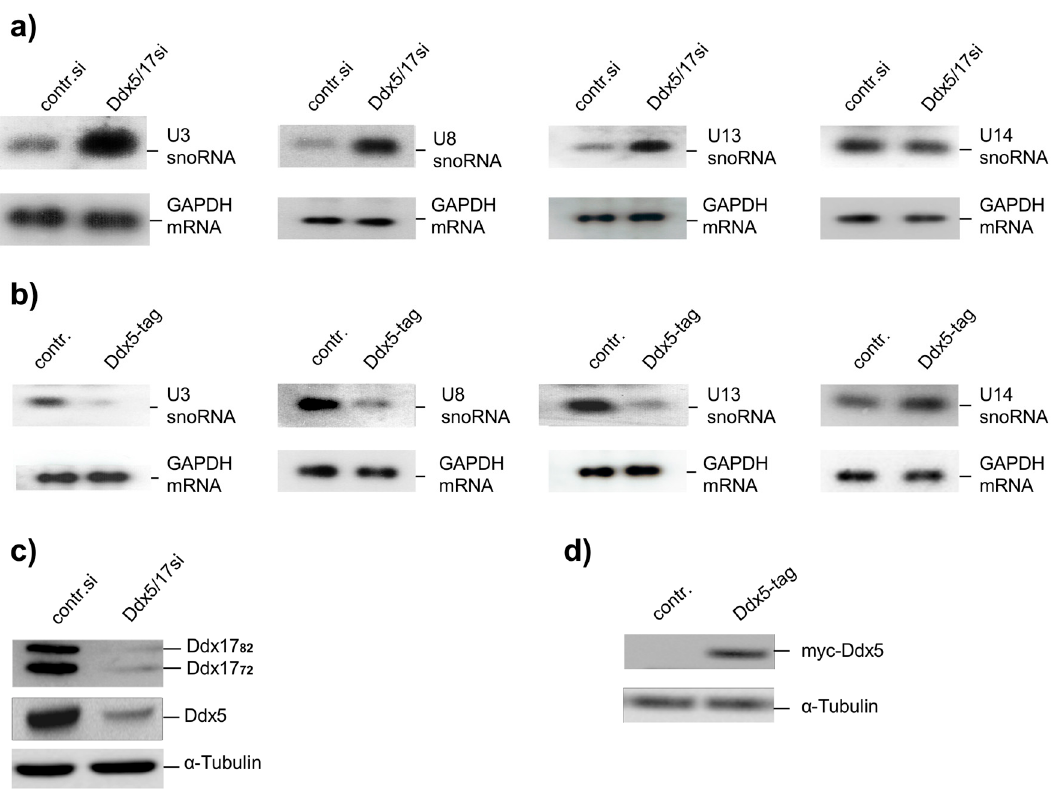
Figure 1. Effect of DEAD box proteins Ddx5/Ddx17 on the expression of U3-, U8-, U13-, and U14 small nucleolar RNA (snoRNA). ( a ) Northern blot analysis after knockdown of Ddx5/Ddx17. Total RNA (5 µ g each) from HeLa cells transfected with indicated small interfering RNA (siRNA) for 48 h were analyzed using digoxigenin-labeled snoRNA probes and a glyceraldehyde 3-phosphate dehydrogenase (GAPDH) mRNA probe, the latter serving as an endogenous loading control; ( b ) Northern blot analysis after overexpression of Ddx5. HeLa cells were transfected with a Ddx5 expression plasmid (Ddx5-tag) for 48 h, thereafter the total RNA was extracted and analyzed as in Figure 1a; ( c ) Demonstration of efficient Ddx5/Ddx17 knockdown by Western blot analysis with α -tubulin as an endogenous loading control; ( d ) Demonstration of ectopic Ddx5 expression (Ddx5-myc) by Western blot analysis with myc antibodies. α -Tubulin was used as an endogenous loading control.